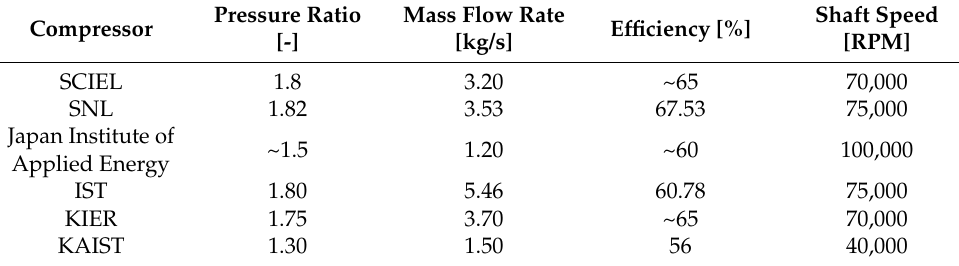
Table 3. S-CO 2 Compressor Experimental Facility Design Values